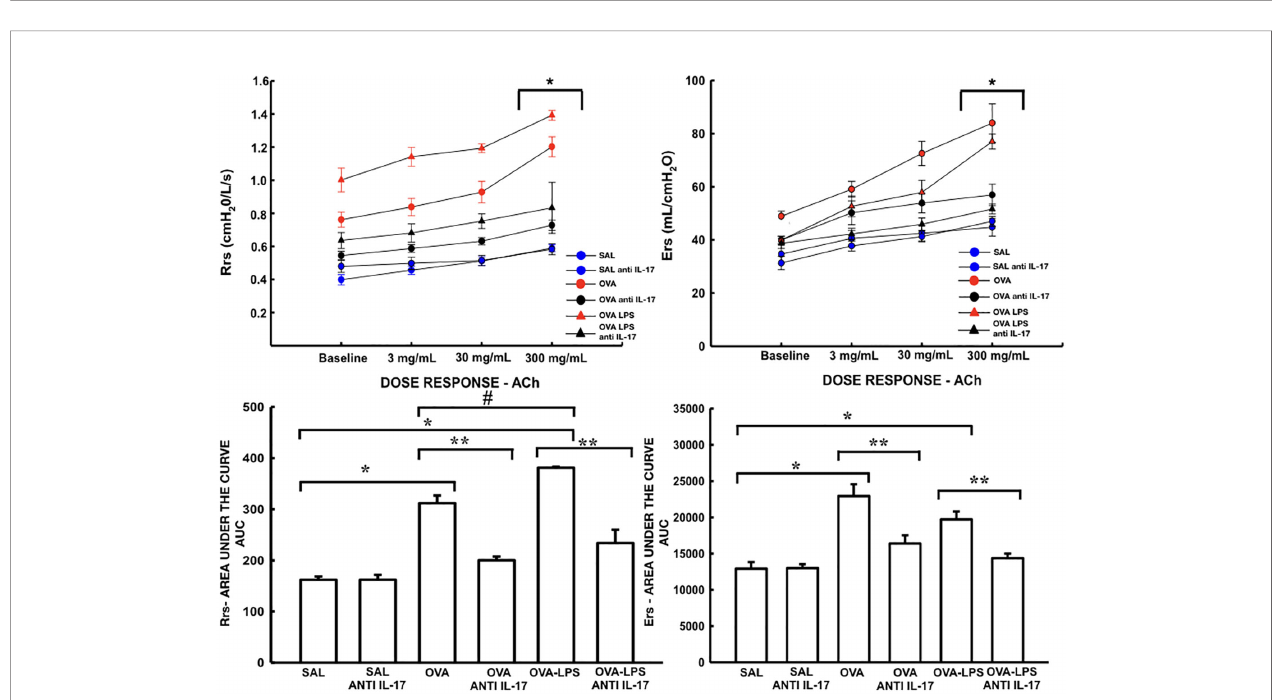
FIGURE 5 | Effects of anti-IL-17 treatment on resistance (Rrs) and elastance (Ers). Dose/response curves of methacholine dose/3, 30, and 300 mg/ml. Data are presented as mean ± sem. The differences were considered signi fi cant when p < 0.05. *p < 0.05 vs. baseline. Values of the logarithm of the area under the curve (AUC) of resistance (Rrs) and elastance of the respiratory system (Ers) were considered a signi fi cant difference when p < 0.05. *p<0.05 vs. SAL group; **p<0.05 vs. OVA and OVA – LPS groups. #p<0.05 vs. OVA